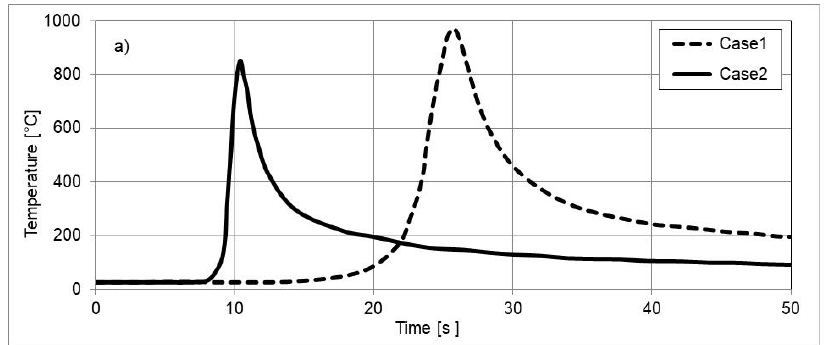
Table 8. Difference between measured maximum depths of the increased hardness for QT and N samples using two different sets of technological parameters (Cases 1 and 2).